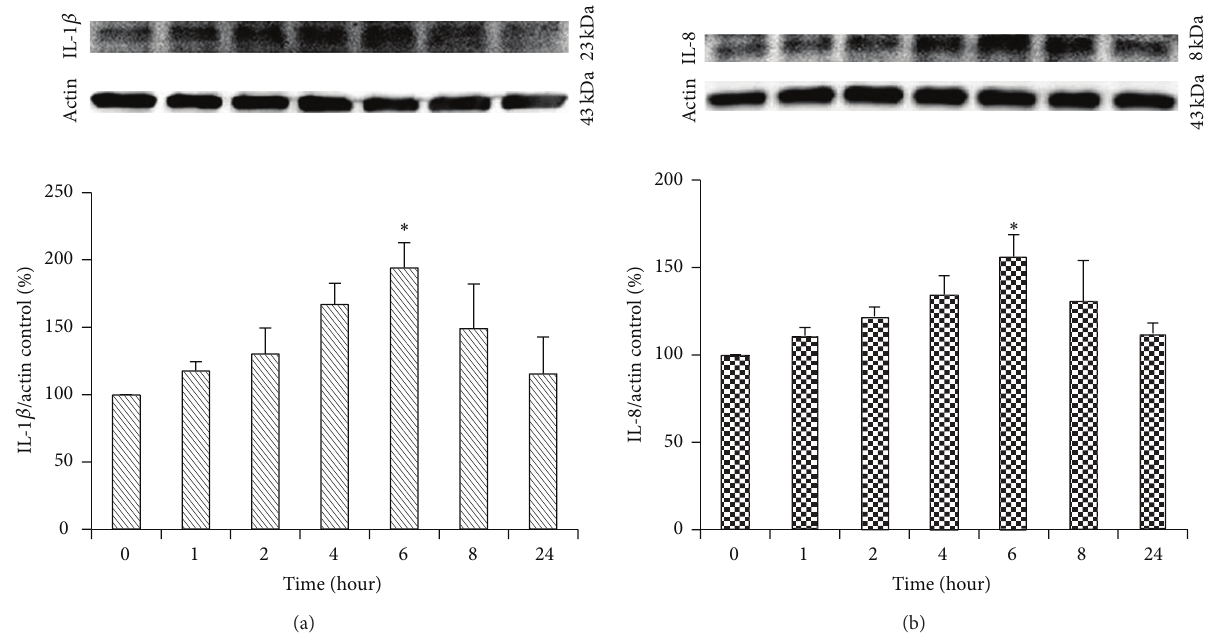
Figure 2: Effect of H 2 O 2 on the expression of IL-1 𝛽 and IL-8 in feline EECs. The time course of cytokines expression in feline EECs. Feline EECs were exposed to 300 𝜇 M H 2 O 2 . (a) Representative Western blot analyses of IL-1 𝛽 expressed in feline EECs ( 𝑛 = 3 ). Actin expression was usedasaloadingcontrolfornormalization.(b)RepresentativeWesternblotanalysesofIL-8expressedinfelineEECs( 𝑛 = 3 ).Actinexpression was used as a loading control for normalization. Data are expressed as means ± S.E of three experiments (Student’s t -test; ∗ 𝑃 < 0.05 versus